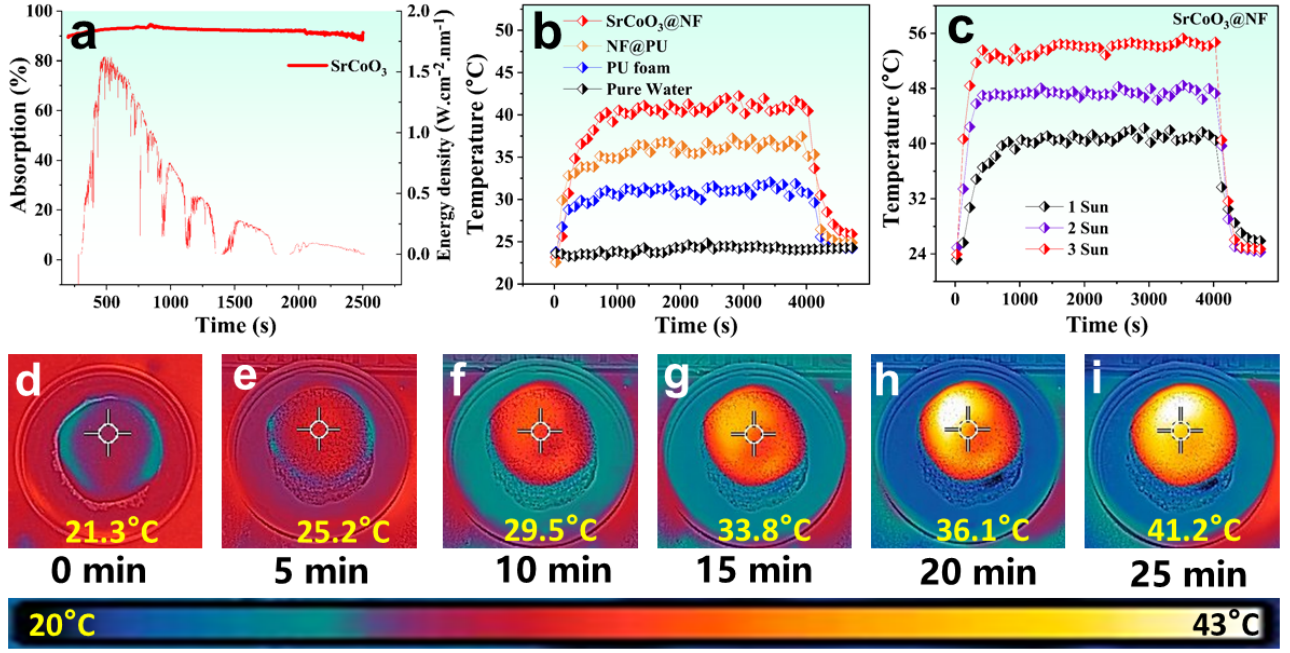
Figure 3. ( a – c ) FESEM images of SrCoO 3 nanoparticles at different resolutions. ( d ) FESEM image of SrCoO 3 -coated nickel foam.